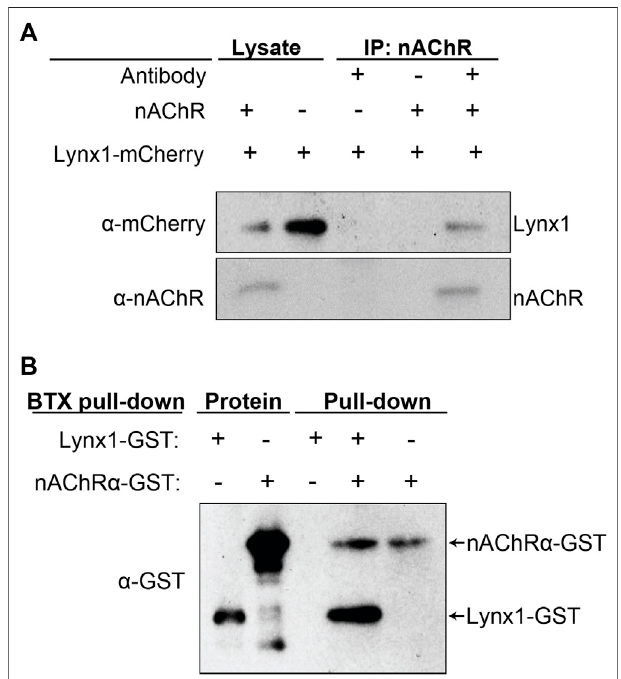
FIGURE 2 | Lynx1 interacts with nicotinic acetylcholine receptors (nAChRs). (A) nAChR co-immunoprecipitation (co-IP) of HEK293 cells co- transfected with Lynx1-mCherry and the α 1, β 1, δ , and ε nAChR subunits. Western blot was performed with anti-mCherry or anti-nAChR antibodies. Lane 1, cell lysate transfected with Lynx1-mCherry and nAChR subunits. Lane 2, cell lysate transfected with Lynx1-mCherry only. Lane 3, nAChR co-IP of cell lysate transfected with Lynx1-mCherry only. Lane 4, no antibody co-IP of cell lysate transfected with Lynx1-mCherry and nAChR subunits. Lane 5, nAChR co-IP of cell lysate transfected with Lynx1-mCherry and nAChR subunits. (B) α -bungarotoxin (BTX) pull-down of puri fi ed recombinant glutathione S-transferase (GST)-tagged truncated α 1 nAChR and GST-tagged Lynx1. Western blot was performed with a GST antibody. Lanes 1 and 2 show GST-tagged Lynx1 and GST-tagged truncated α 1 nAChR at their predicted sizes. Lanes 3 – 5 show BTX pull-down products of samples with and without recombinant GST-tagged truncated α 1 nAChR or GST-tagged Lynx1. n ≥